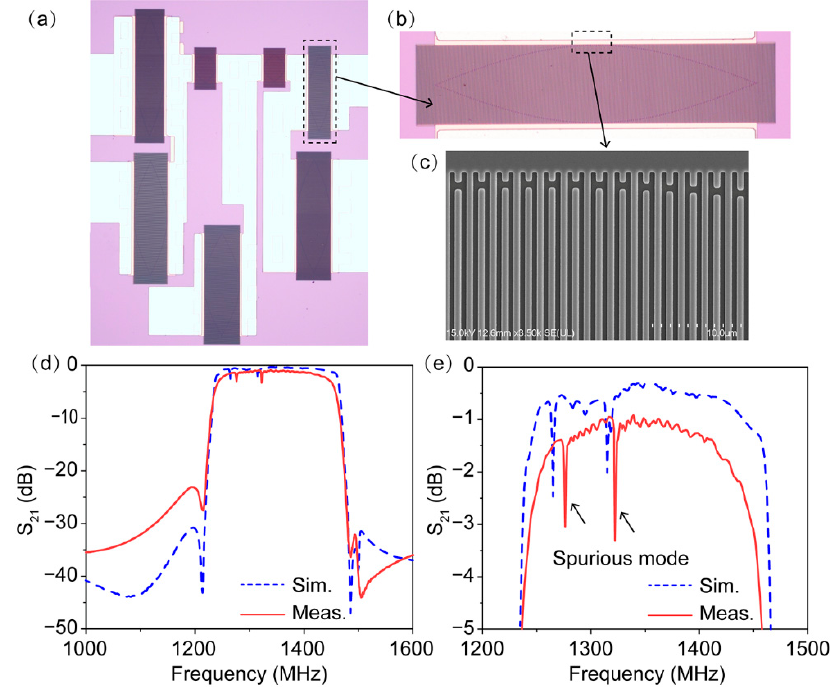
Figure 2. ( a ) Optical microscope image of the fabricated filter using the conventional design; ( b ) zoomed-in optical microscope image; ( c ) SEM image of the IDT fingers; ( d ) simulated and measured frequency responses of the filter; ( e ) zoomed-in simulated and measured frequency responses of the filter.